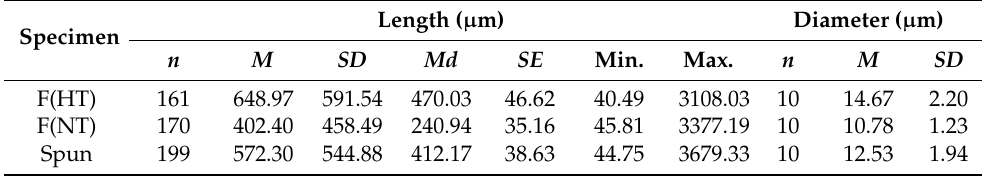
Table 2. Descriptive Statistics of Fiber Length and Diameter of Microplastics